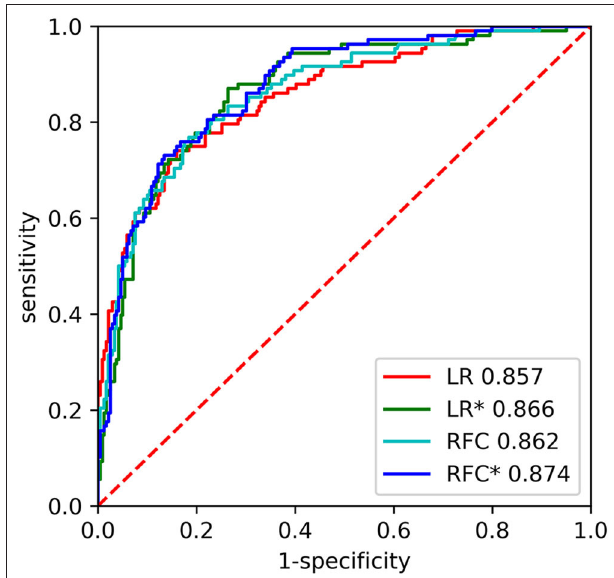
FIGURE 4 | The receiver operating characteristic (ROC) curves of the random forest classifier (RFC) and logistic regression (LR) on the testing set. * indicates model developed with 21 variables.